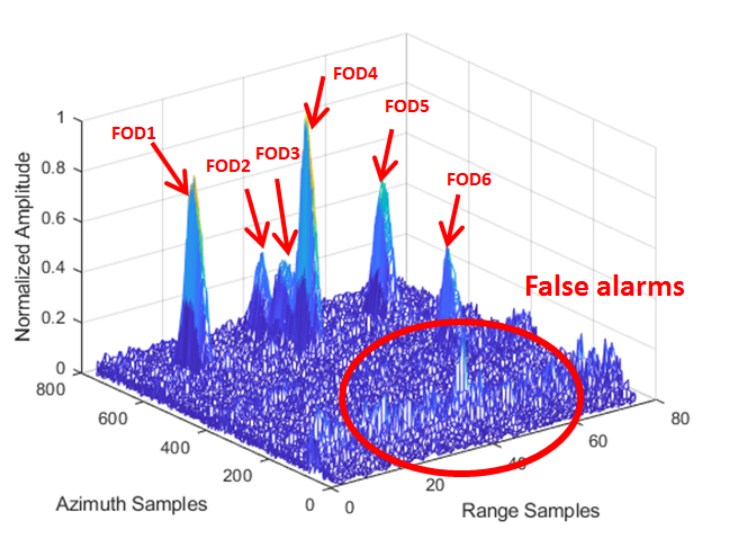
Figure 9. Before IAA processing of the area of Scene